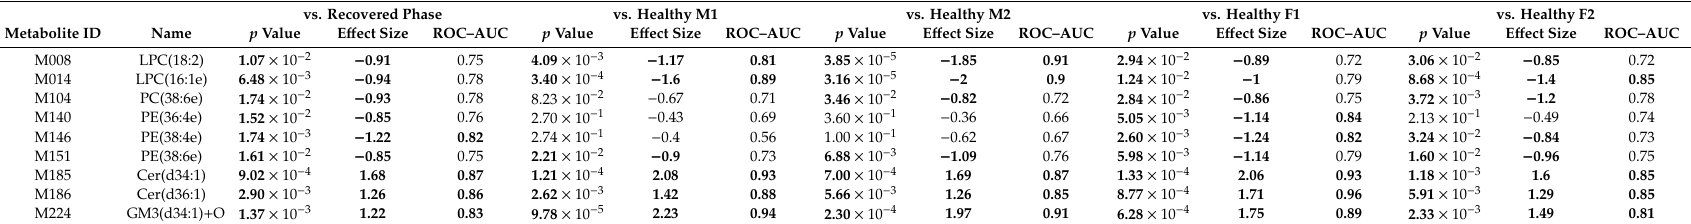
Table 3. Specific lipids altered in mixed-type